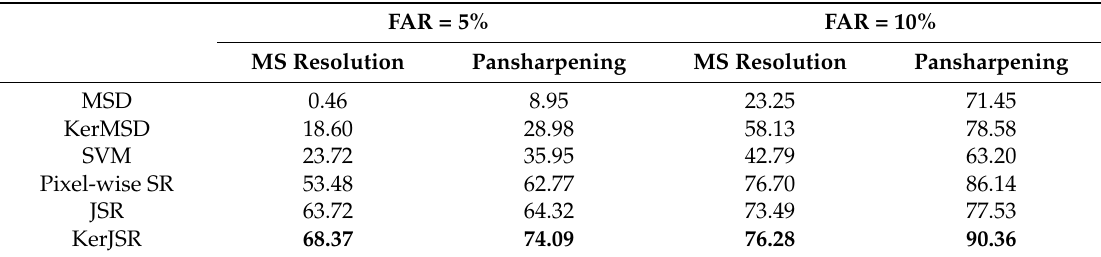
Figure 6. Visual comparison before and after pansharpening for RGB and SWIR images: ( a ) MS RGB band (2 m); ( b ) pansharpened RGB (0.5 m); ( c ) original SWIR image (7.5 m); and ( d ) pansharpened SWIR image (0.5 m). Table 1. Comparison of detection accuracies for test date 19 March 2010 with false alarm rates (FAR) of 5% and 10%. Bold number highlight best performing methods.